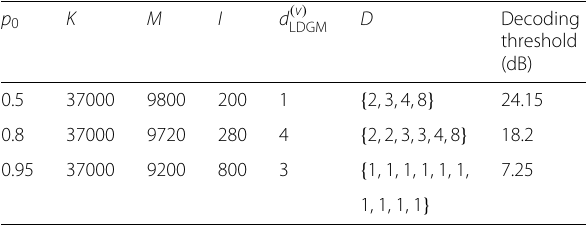
Table 1 Best configurations obtained by the EXIT chart analysis for AWGN